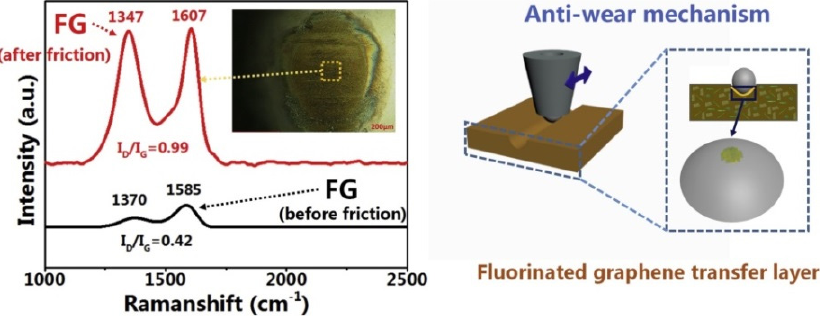
Figure 9. A schematic presentation of the tribological mechanism for the ‘PI + FG’ nanocomposites. Figure is reproduced with permission from reference [55].